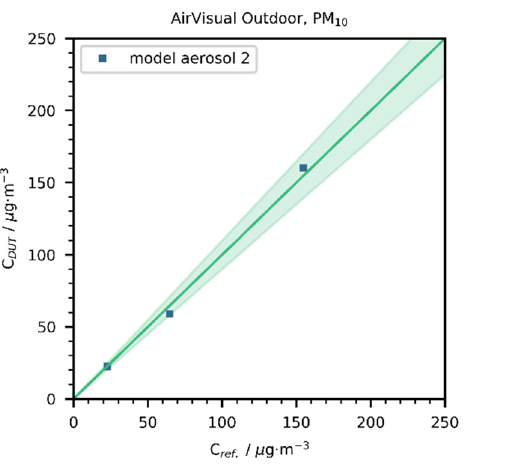
Figure 5. PM 10 mass concentrations reported by the AirVisual Outdoor and SDS011 as a function of time (model aerosol 2). The green line refers to the average mass concentration over the whole measurement period according to the gravimetric reference method, while the shaded green area designates the expanded uncertainty ( k = 2; 95% confidence interval) thereof.